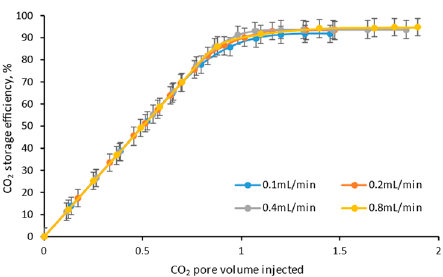
Figure 12. Relation curves between long core CO 2 storage efficiency and injection volume under different injection rates.